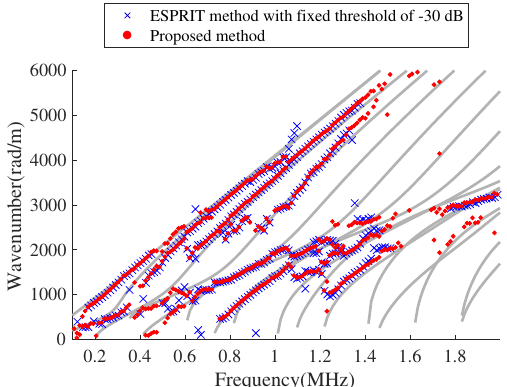
Figure 9. Wavenumbers of the 4-mm-thick bone-mimicking plate estimated using the conventional estimation of signal parameters via rotational invariance technique (ESPRIT) algorithm at a fixed threshold of − 40 dB and the proposed method. Red dots show the estimates obtained using the proposed method and blue cross marks show the estimates obtained using the conventional method. Solid gray lines show the theoretical curves.